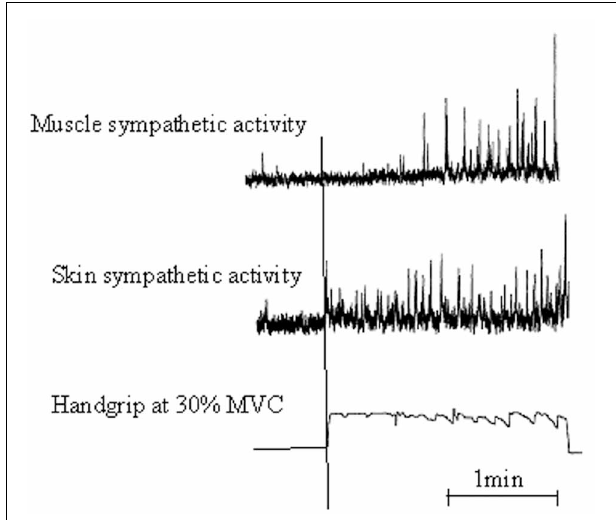
FIGURE 1 | Illustrative recording from a participant showing a 2-min sequence of static handgrip at 30% maximal voluntary contraction [Adapted with permission from Vissing et al. (1991), Circulation Research]. Muscle and skin sympathetic nerve activity are recorded from left and right peroneal nerves. Static handgrip markedly increased both skin and muscle sympathetic nerve activity. However, skin ANS increased rapidly and anticipated the onset of handgrip, whereas muscle ANS increased much more slowly with a latency of almost 1min from the onset of handgrip to the onset of sympathetic